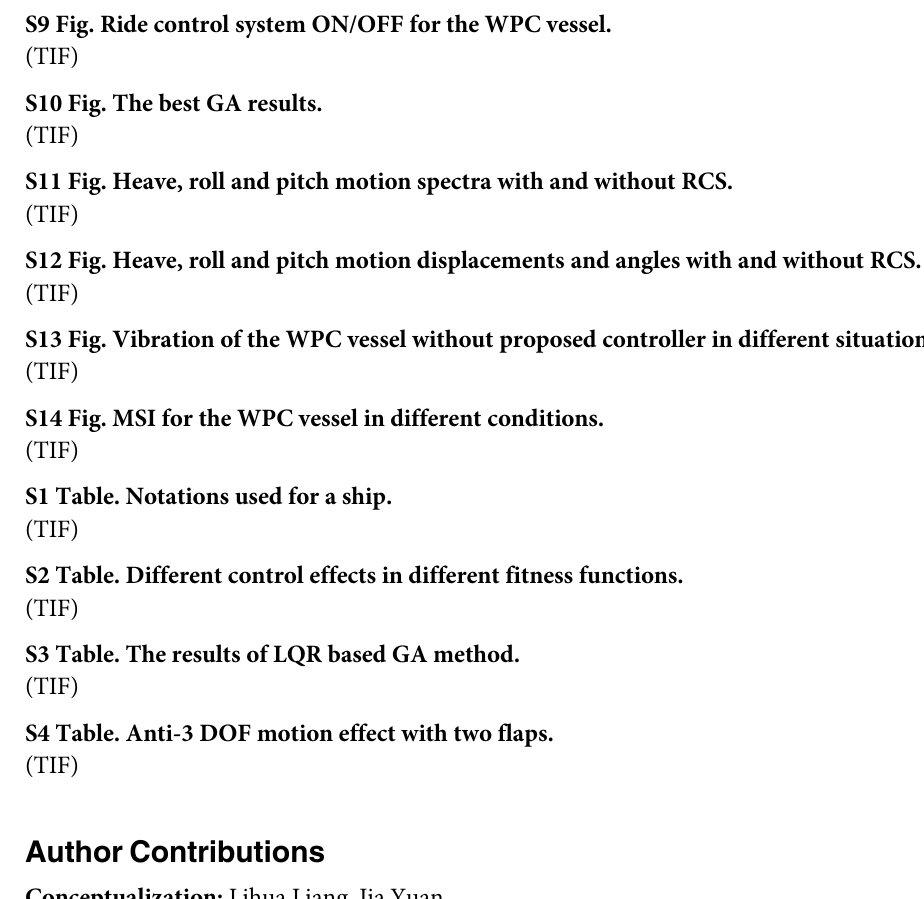
S1 Fig. Standard notation and sign conventions for a ship motion description. (TIF) S2 Fig. The longitudinal hydrodynamic parameters in different situations. (TIF) S3 Fig. Free roll motion of the WPC vessel. (TIF) S4 Fig. Disturbing forces and moments. (TIF) S5 Fig. Encounter angles and roll RAO. (TIF) S6 Fig. An anti-3 DOF motion system with two flaps. (TIF) S7 Fig. The dynamic lift coefficient curve of two flaps. (TIF) S8 Fig. Lift coefficient fitting curves in different speeds. (TIF) S9 Fig. Ride control system ON/OFF for the WPC vessel. (TIF) S10 Fig. The best GA results. (TIF) S11 Fig. Heave, roll and pitch motion spectra with and without RCS. (TIF) S12 Fig. Heave, roll and pitch motion displacements and angles with and without RCS. (TIF) S13 Fig. Vibration of the WPC vessel without proposed controller in different situations. (TIF) S14 Fig. MSI for the WPC vessel in different conditions. (TIF) S1 Table. Notations used for a ship. (TIF) S2 Table. Different control effects in different fitness functions. (TIF) S3 Table. The results of LQR based GA method. (TIF) S4 Table. Anti-3 DOF motion effect with two flaps.